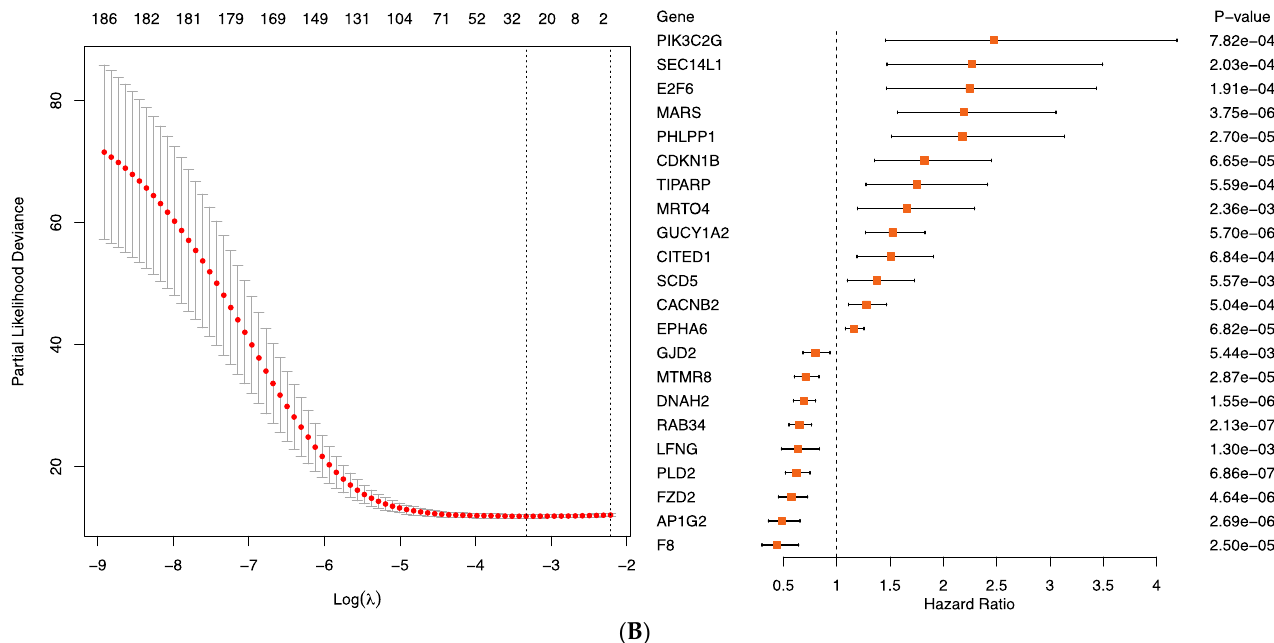
Figure 5. Construction of a prognostic gene expression signature for TYAs with medulloblastoma. ( A ) Kaplan – Meier analysis of overall survival (OS) for medulloblastoma (MB) patients stratified by molecular subgroups in the TYA and adult age groups. ( B ) The risk score model was constructed using the LASSO regression analysis along with 10-fold cross-validation in the entire dataset. The partial likelihood deviance with changing of log ( λ ) was plotted (left). The number corresponded to the point with the smallest cross-verification error was the gene numbers included in the LASSO regression risk model. The hazard ratio (HR) and 95% confidence interval for all 22 genes were calculated by univariate Cox regression analysis.